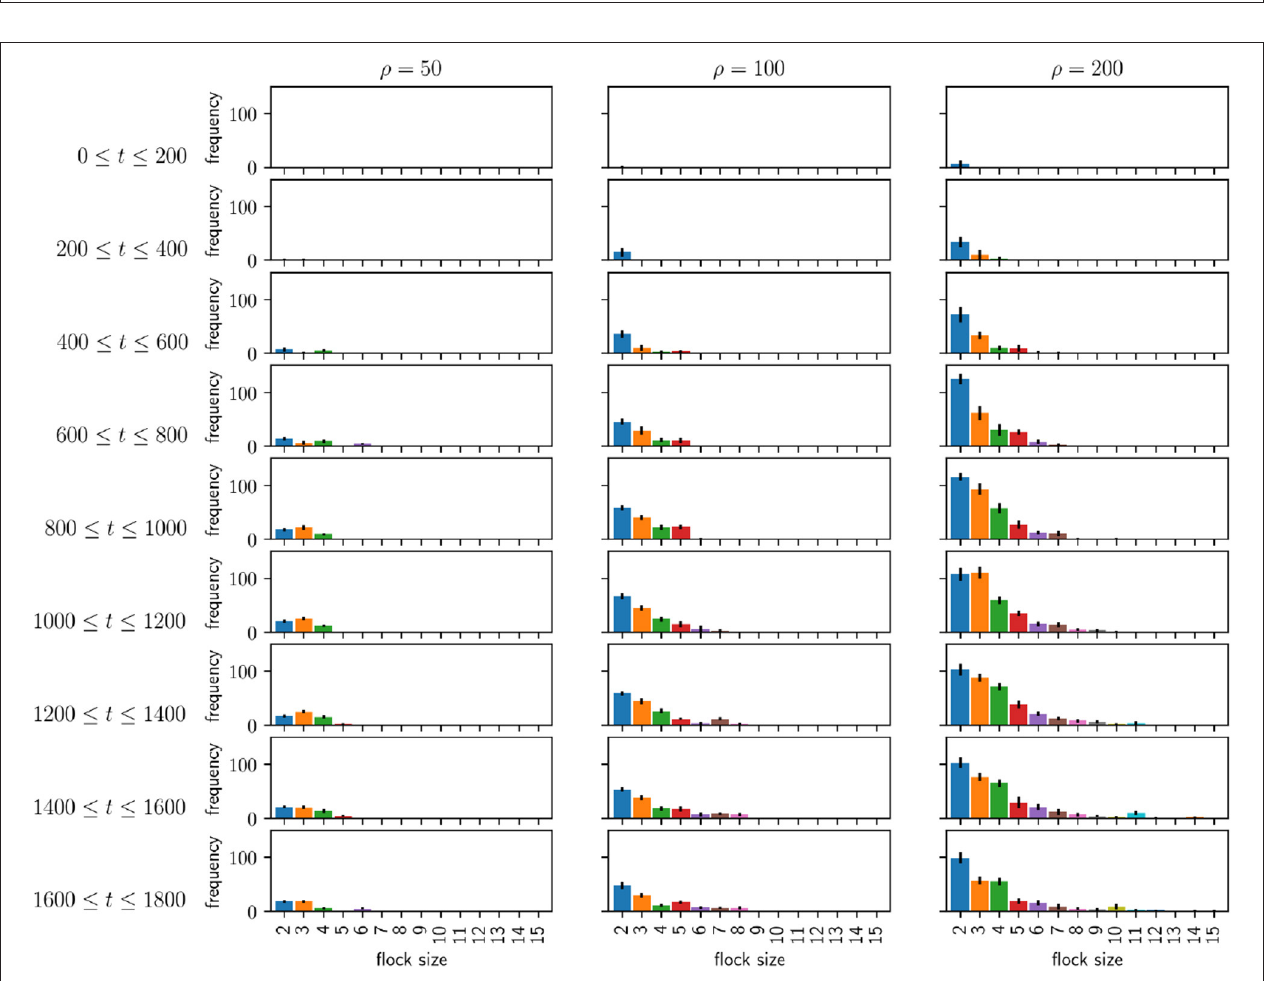
FIGURE 4 | Distribution of flock size for densities ρ = 50, ρ = 100, and ρ = 200 at lapses of 200 simulation steps. Higher densities yield larger flocks.